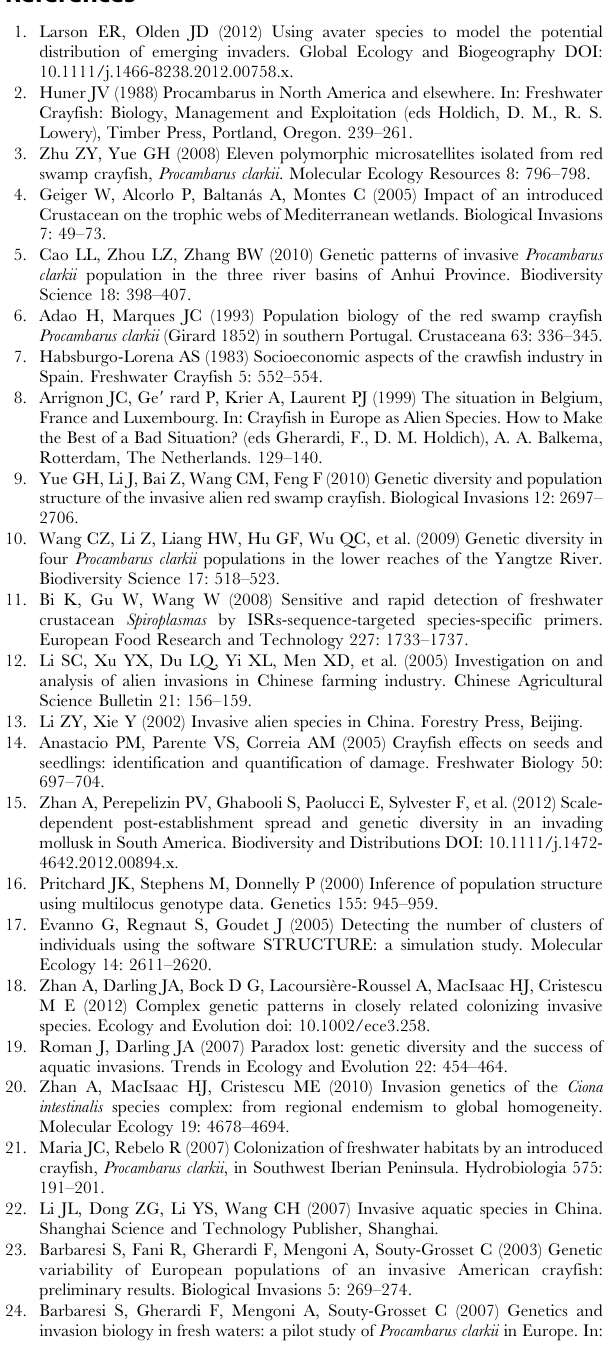
Table S1 List of the populations of P. clarkii studied indicating the location, their country of origin, geo- graphical position of sampling sites, genetic diversity at 12 microsatellite loci, and haplotype diversity at mtDNA COI and 16S rRNA